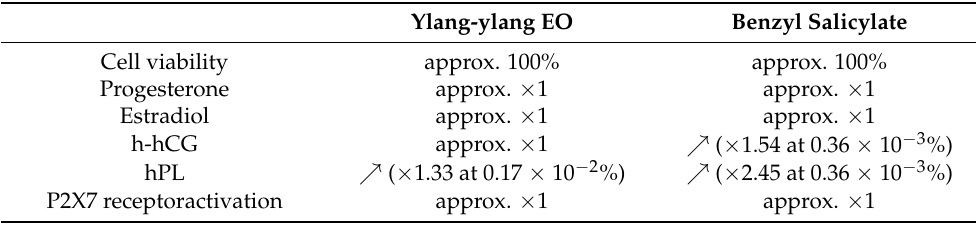
Table 6. Summary of the results of ylang-ylang EO compared to benzyl salicylate. Ylang-ylang EO Benzyl Salicylate Cell viability approx. 100% approx. 100% Progesterone approx. × 1 approx. ×